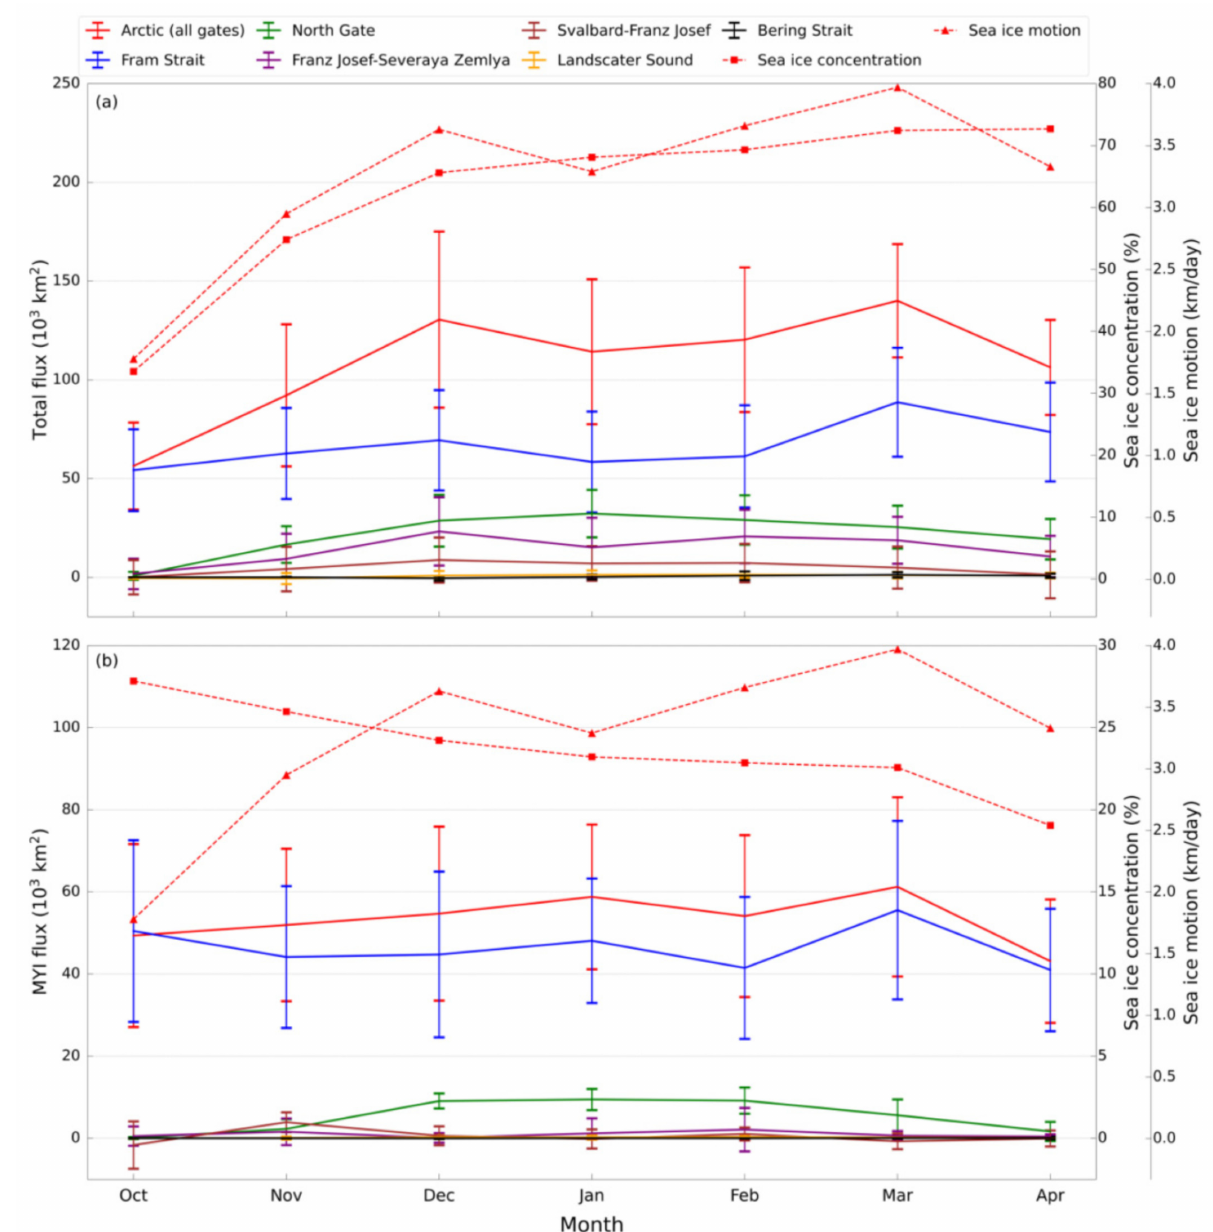
Figure 5. The monthly areal flux of ( a ) total sea ice and ( b ) MYI for each fluxgate. Red dotted lines with rectangle and triangle markers represent the mean sea ice concentration and motion of the Arctic,